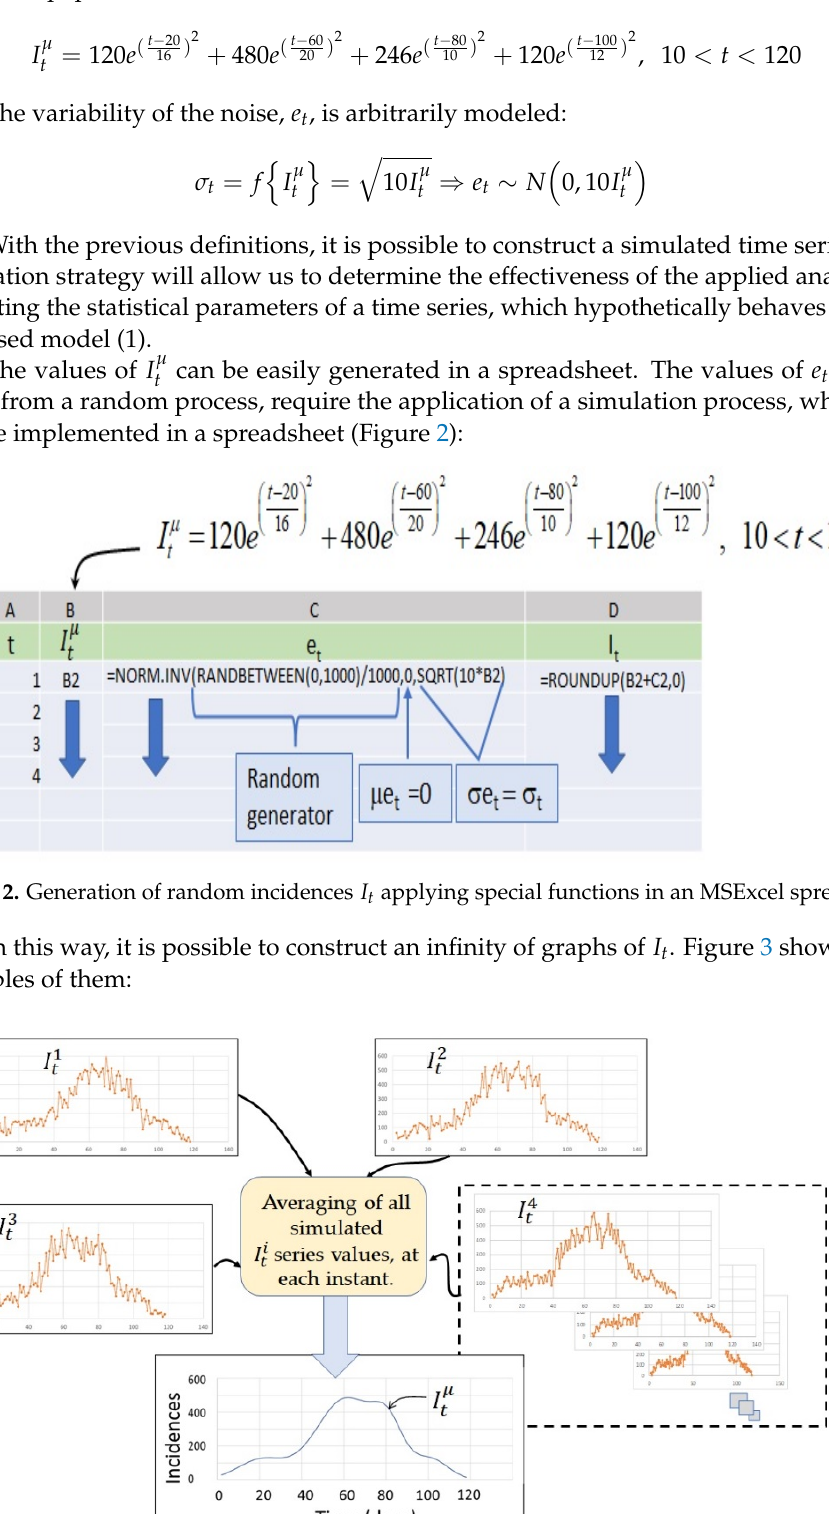
Figure 3. Random incidence series and reconstruction of the mean by averaging of them. The proximity of the calculated mean curve to the real mean curve of the population is better as the number of incidence series added increases.